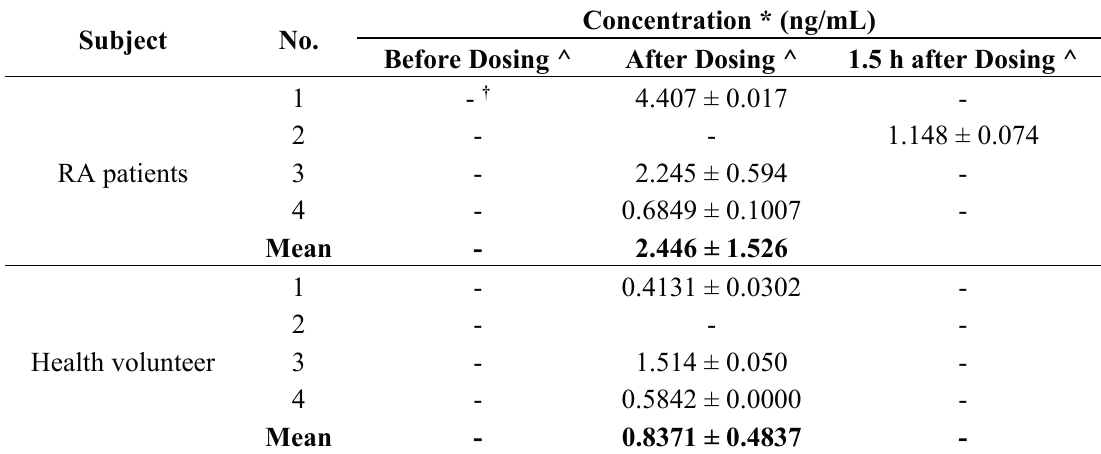
Table 3. Sinomenine concentration in the plasma